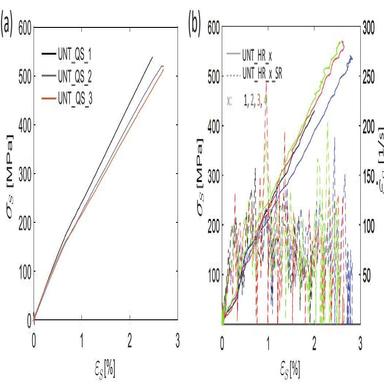
Tensile stress-strain curves in the longitudinal direction at QS (a) and HR (b) loading.